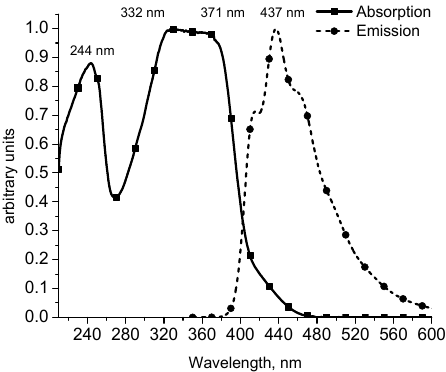
Figure 3. Absorption and emission ( λ ex = 350 nm) spectrum of Compound 2 in THF.